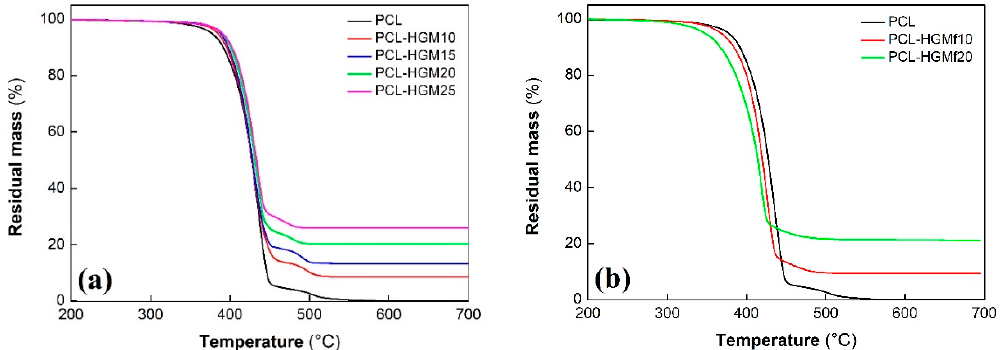
Figure 6. TGA curves in air atmosphere of PCL and PCL–HGM composites ( a ), PCL and PCL–HGMf composites ( b ). Table 2. TGA data under oxidative atmosphere for PCL and PCL-based composites.